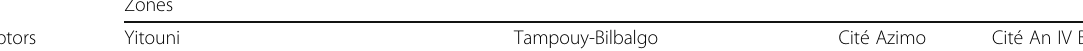
Table 4 Implementation fidelity analysis